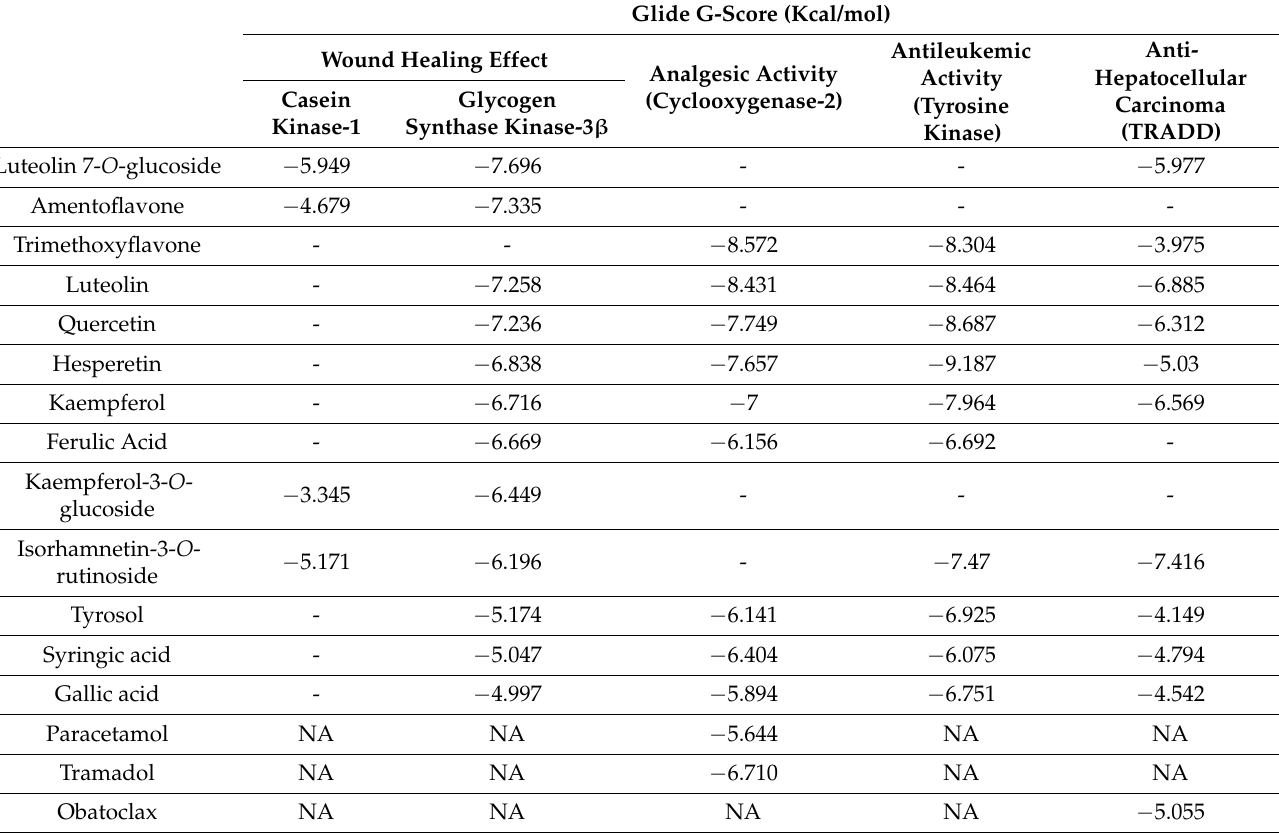
Table 3. Docking results with ligands in Casein kinase-1, Glycogen synthase kinase-3 β , cyclooxygenase-2, Tyrosine kinase, and TRADD receptors. Glide G-Score (Kcal/mol) Wound Healing